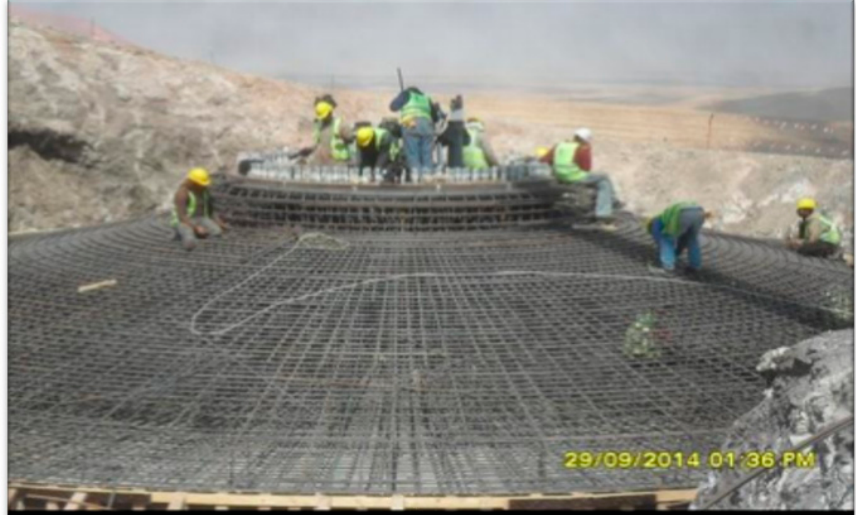
Figure A2. TWF foundation and reinforcement works.